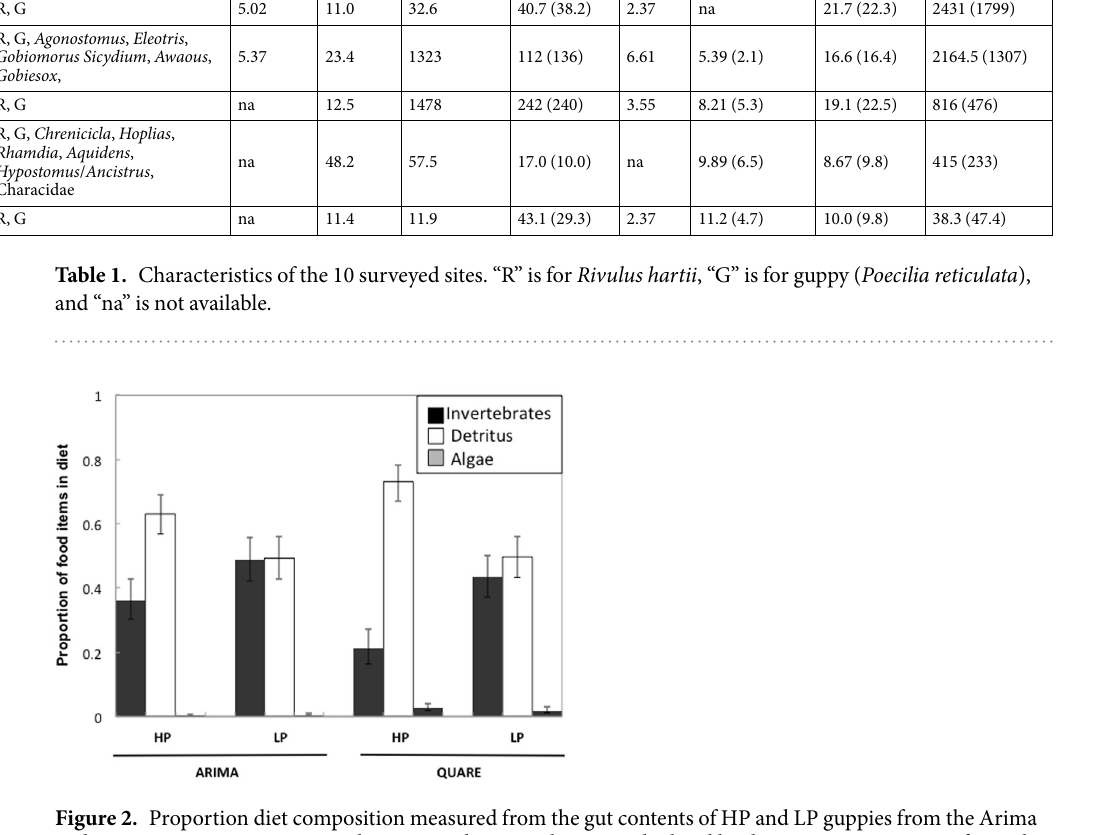
Figure 2. Proportion diet composition measured from the gut contents of HP and LP guppies from the Arima and Quare rivers. Data represent the estimated marginal means calculated by the GLM on arcsin transformed data, and have been back-transformed for the graphical representation. Food categories are invertebrates (dark grey), amorphous detritus (white), and algae (light